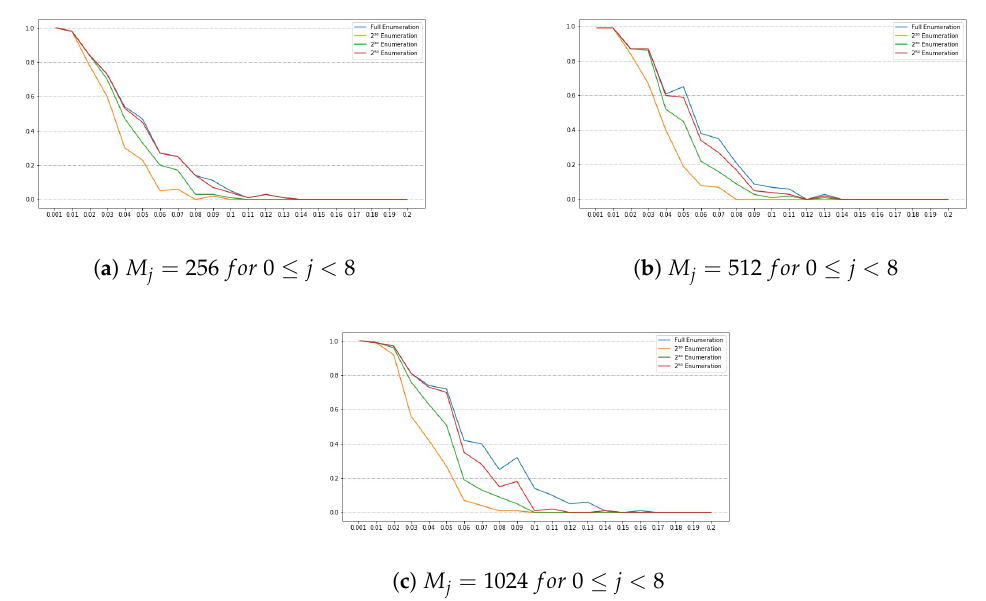
Figure 5. Success rates for the SIKE parameters SIKEp610 for α = 0.001. The y -axis denotes the success rate, while the x -axis denotes β